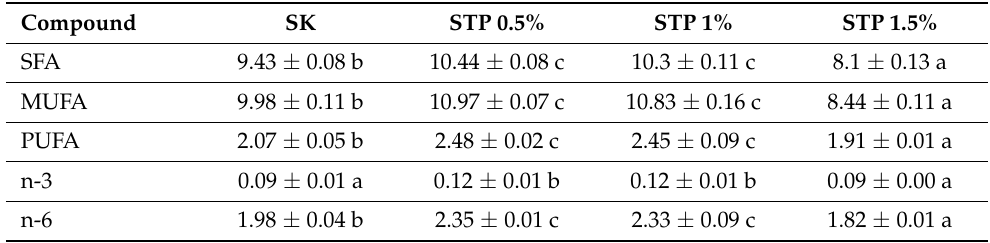
Table 4. Main fractions of the fatty acid profile (g/100 g) of dry fermented sausages. Compound